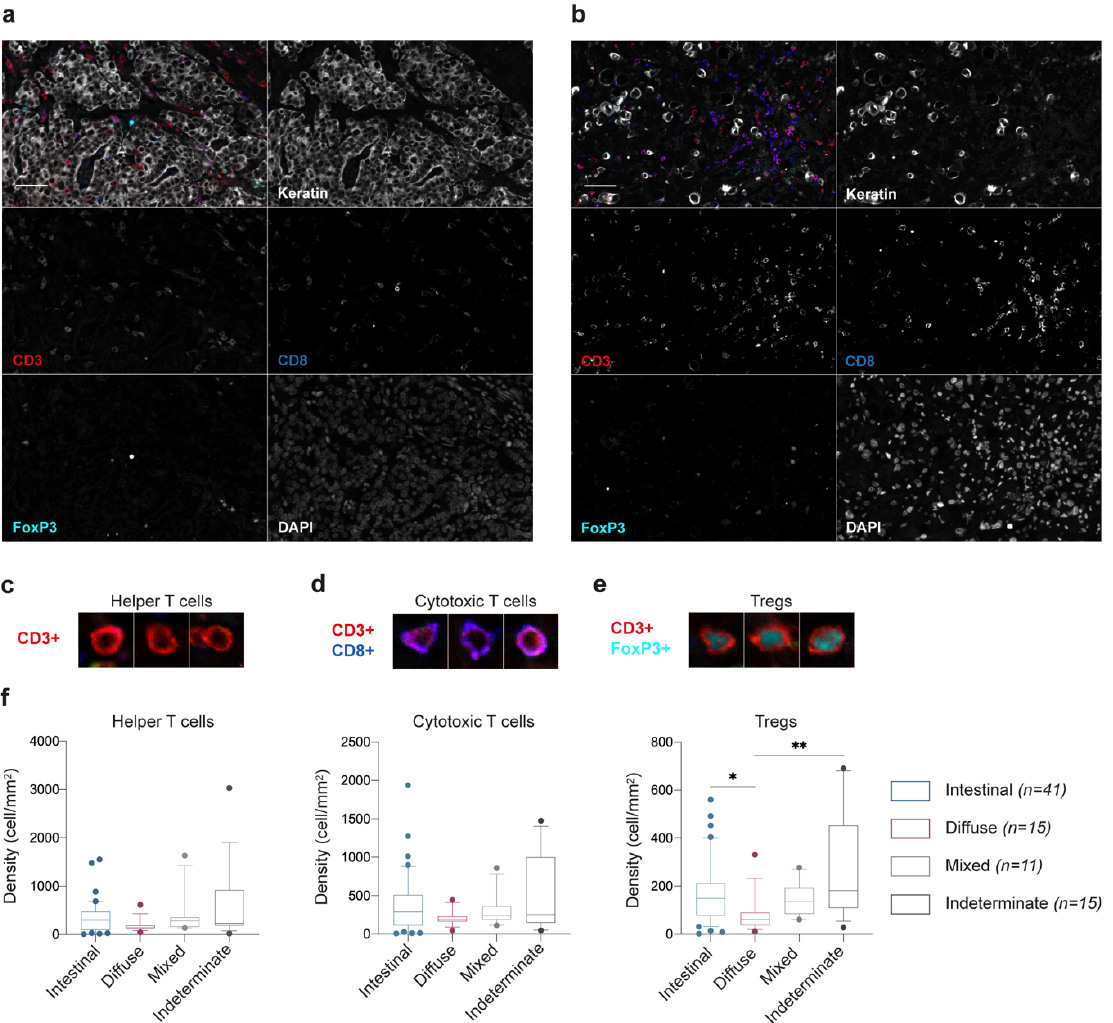
Figure 1. Characterization of the immune T cell landscape in gastric cancer (GC) tissue sections. ( a , b ) Representative composite and single-staining immunofluorescence images of the two main histological GC types, intestinal-type ( a ) and diffuse-type ( b ), obtained by multispectral imaging. Scale bar: 100 µ m. ( c – e ) Main T cell populations identified in the GC microenvironment based on the positivity for CD3, CD8, and FoxP3 cell markers. ( f ) Relative numbers of helper, cytotoxic T cells and Tregs, according to the histologic properties of the tumor: intestinal-type, n = 41; diffuse-type, n = 15; mixed-type, n = 11; indeterminate-type, n = 15 patients. Box and whiskers represent median ± 10 to 90 percentile. * p < 0.05, ** p < 0.01; Kruskal–Wallis test with Dunn’s multiple comparison test.